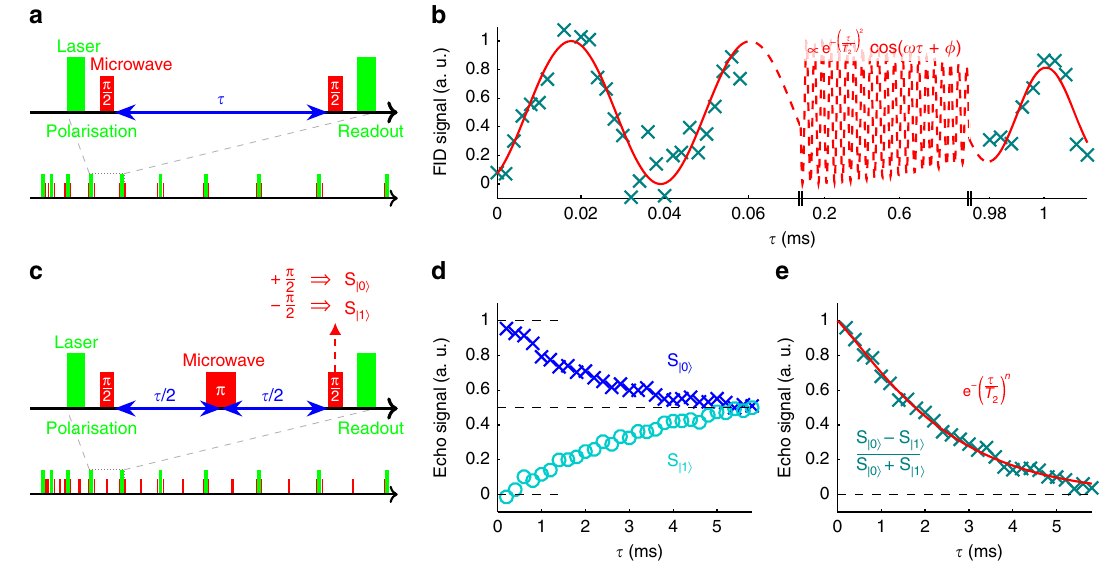
and T 2 in sample C. a Pulse sequence for a free-induction decay (FID) measurement, with a complete sequence illustrated at the bottom. b Result Fig. 2 T (cid:1) 2 ¼ 1 : 54 þ 1 : 91 of FID measurement (data with blue crosses, sinusoidal exponential-decay fi t with red line, T (cid:1) (cid:4) 0 : 50 ms). Please note the breaks on the horizontal 2 axis; all data are fi tted with a single function. c Pulse sequence for a Hahn-echo measurement. When applying a fi nal + π /2-pulse, the spin is rotated towards the |0 〉 state ( S |0 〉 measurement); for a fi nal − π /2-pulse, the spin is rotated towards the |1 〉 state ( S |1 〉 measurement). d Results for the S |0 〉 measurement (blue crosses) and for the S |1 〉 measurement (cyan circles). The top and bottom black dashed lines correspond to a maximum population of the |0 〉 and |1 〉 states, respectively. The middle black dashed line is when both states are populated equally. e Echo signal derived from subtracting d ’ s S |1 〉 ¼ 2 : 43 þ 0 : 06 from d ’ s S |0 〉 (data with blue crosses, exponential-decay fi t with red line, T (cid:4) 0 : 06 ms). The dashed black line at 0 indicates when the states are 2 populated equally